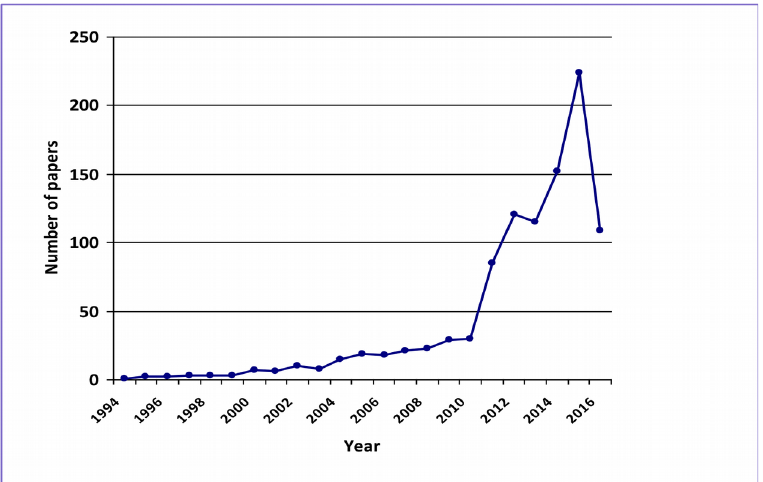
Figure 1. Articles trend in the field of our